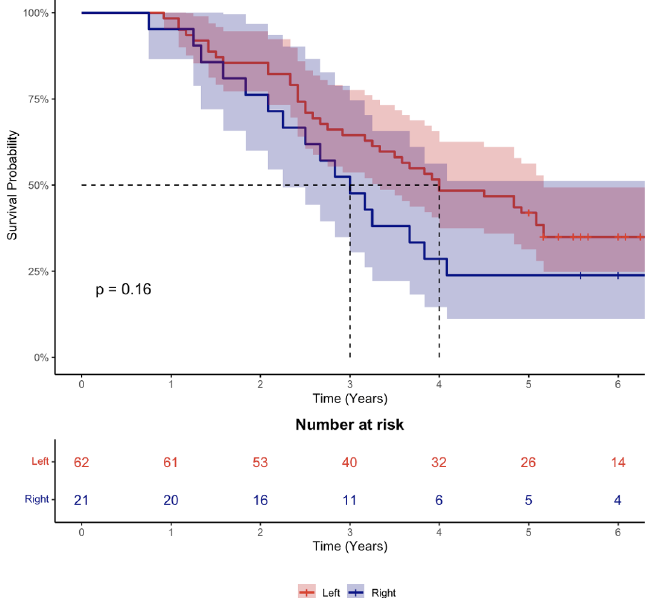
Figure 2. Kaplan–Meier plot of survival by tumour sidedness. Data are presented as median with Figure 2. Kaplan – Meier plot of survival by tumour sidedness. Data are presented as median with 95% confidence interval. 95% confidence After stratifying patients into four groups according to primary tumour sidedness (right vs. left) and KRAS mutation status (wild type vs. mutant), there was no difference in survival (Log-rank test p = 0.27) (Figure 3). Figure 3. Kaplan – Meier of combined KRAS mutation status and sidedness. Data are presented as median with 95% confidence interval.